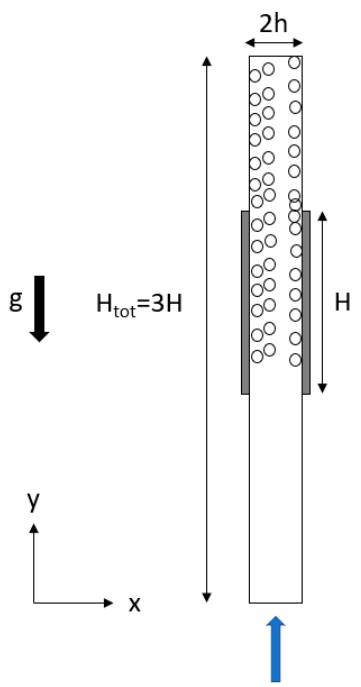
Figure 1. Geometry of the computation domain. h stands for the half-width of the electrolyte, H for the electrode height. The blue arrow symbolizes the pumping electrolyte induced by the electrogenerated bubbles.